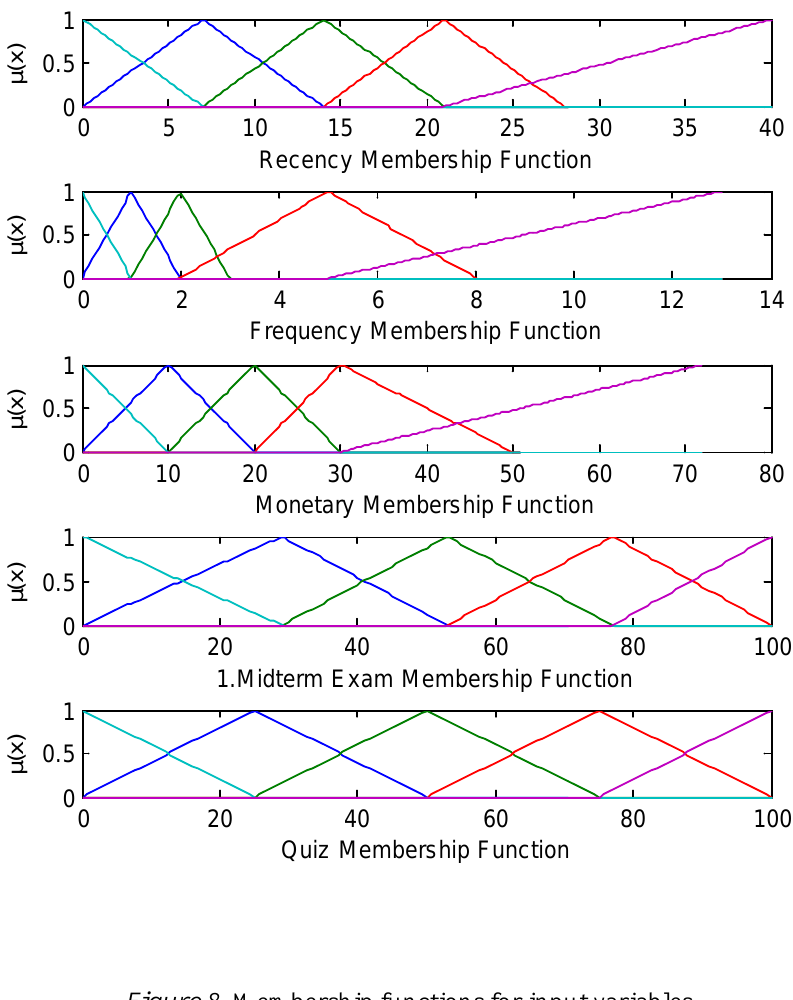
Figure 8 . Membership functions for input